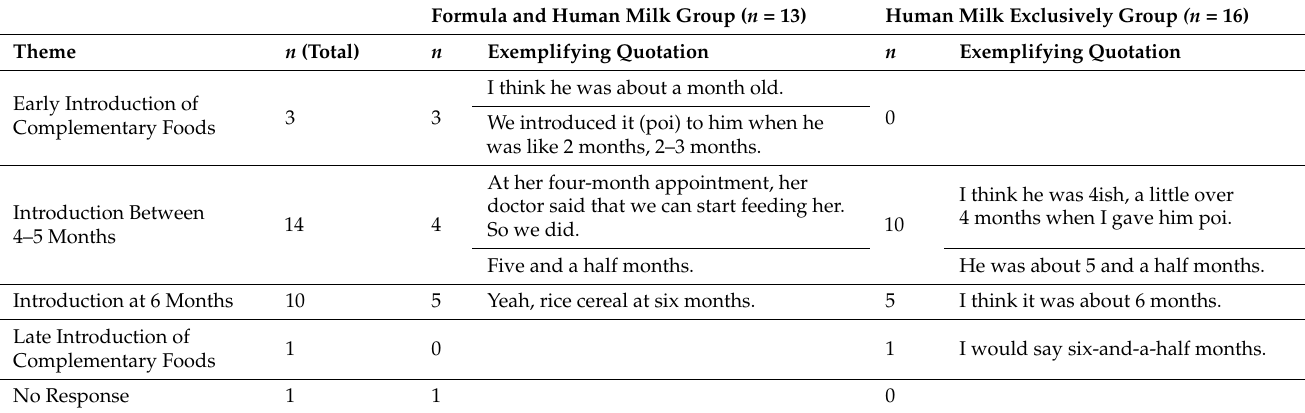
Table 2. Themes and subthemes related to the Timing of the Introduction of Complementary Foods, with exemplifying quotes taken verbatim from in-depth interviews with Native Hawaiian and Other Pacific Islander, and Filipino caregivers, n =